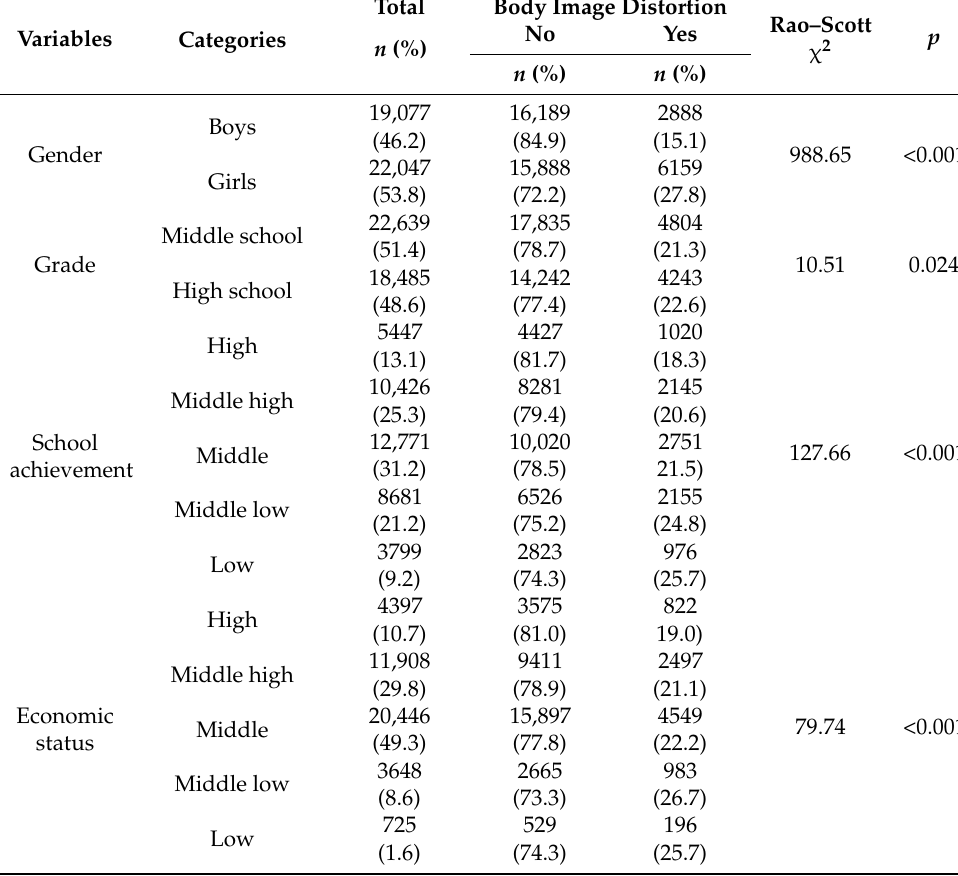
Table 1. Differences in body image distortion by general characteristics ( n =